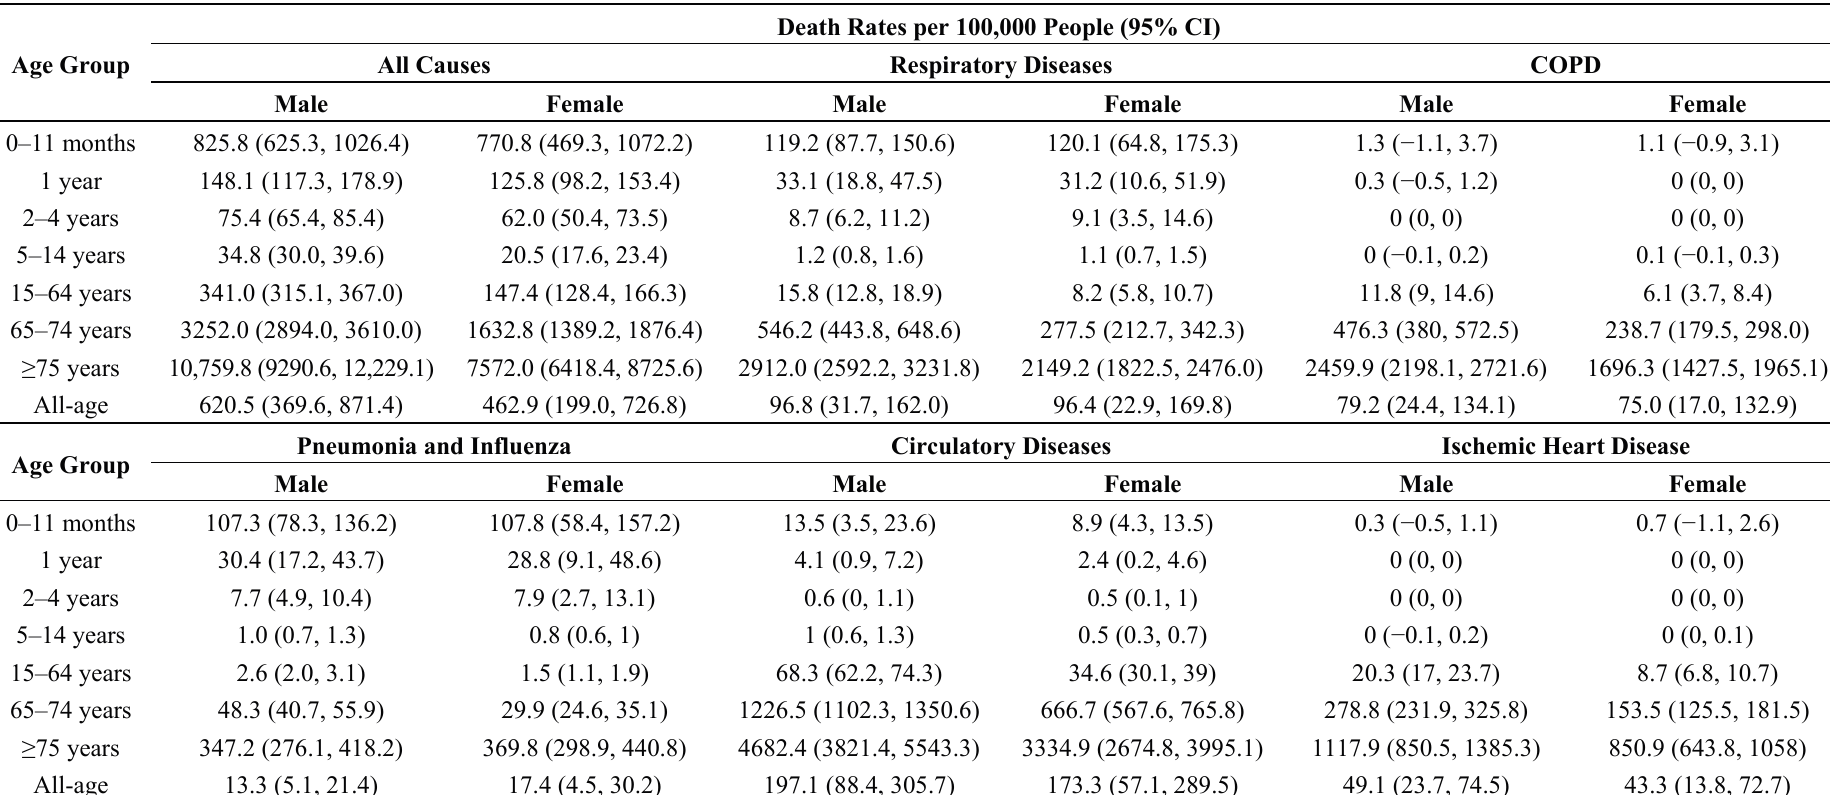
Table 2. Average death rates (per 100,000 people) by age and sex in Southern China,